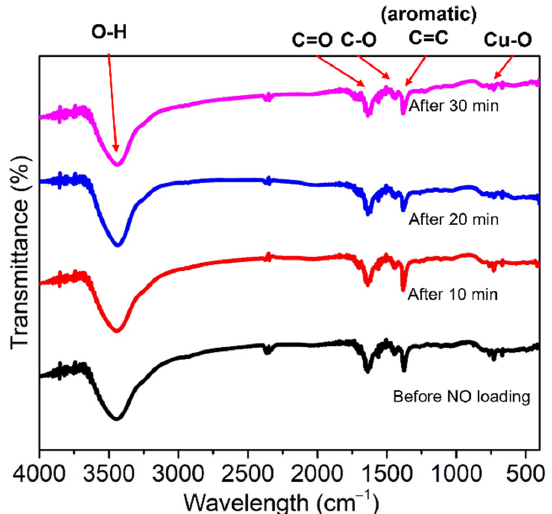
Figure 6. FTIR spectra of 1 (black) and 3 after releasing NO for 10, 20, and 30 min (red, blue, and pink, respectively).